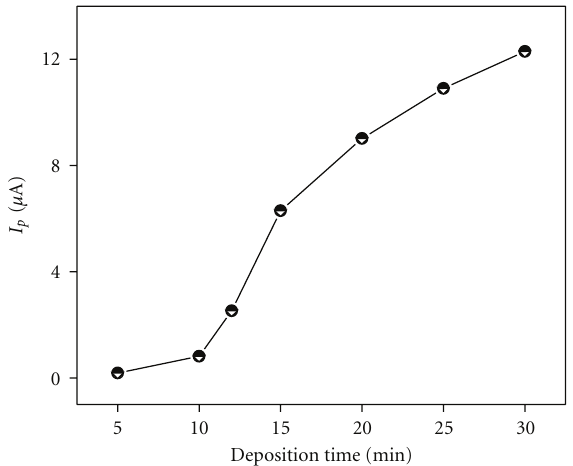
Figure 4: E ff ects of electrode surface concentration of AAP on − 0.8V. The other DPV peak currents for 5 × 10 − 7 molL − 1 Hg 2+ at modified electrode. d : Electrolyte: 0.1mol L − 1 HAc + 0.1molL − 1 NaCl (pH 7.0) solution. E